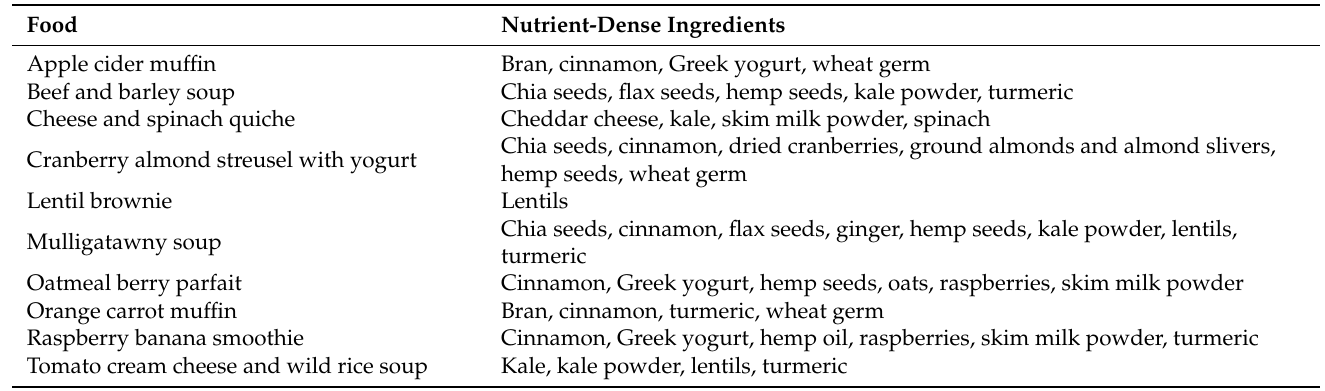
Table 1. Nutrient-dense ingredients in ten foods developed and used for sensory analysis. Food Nutrient-Dense